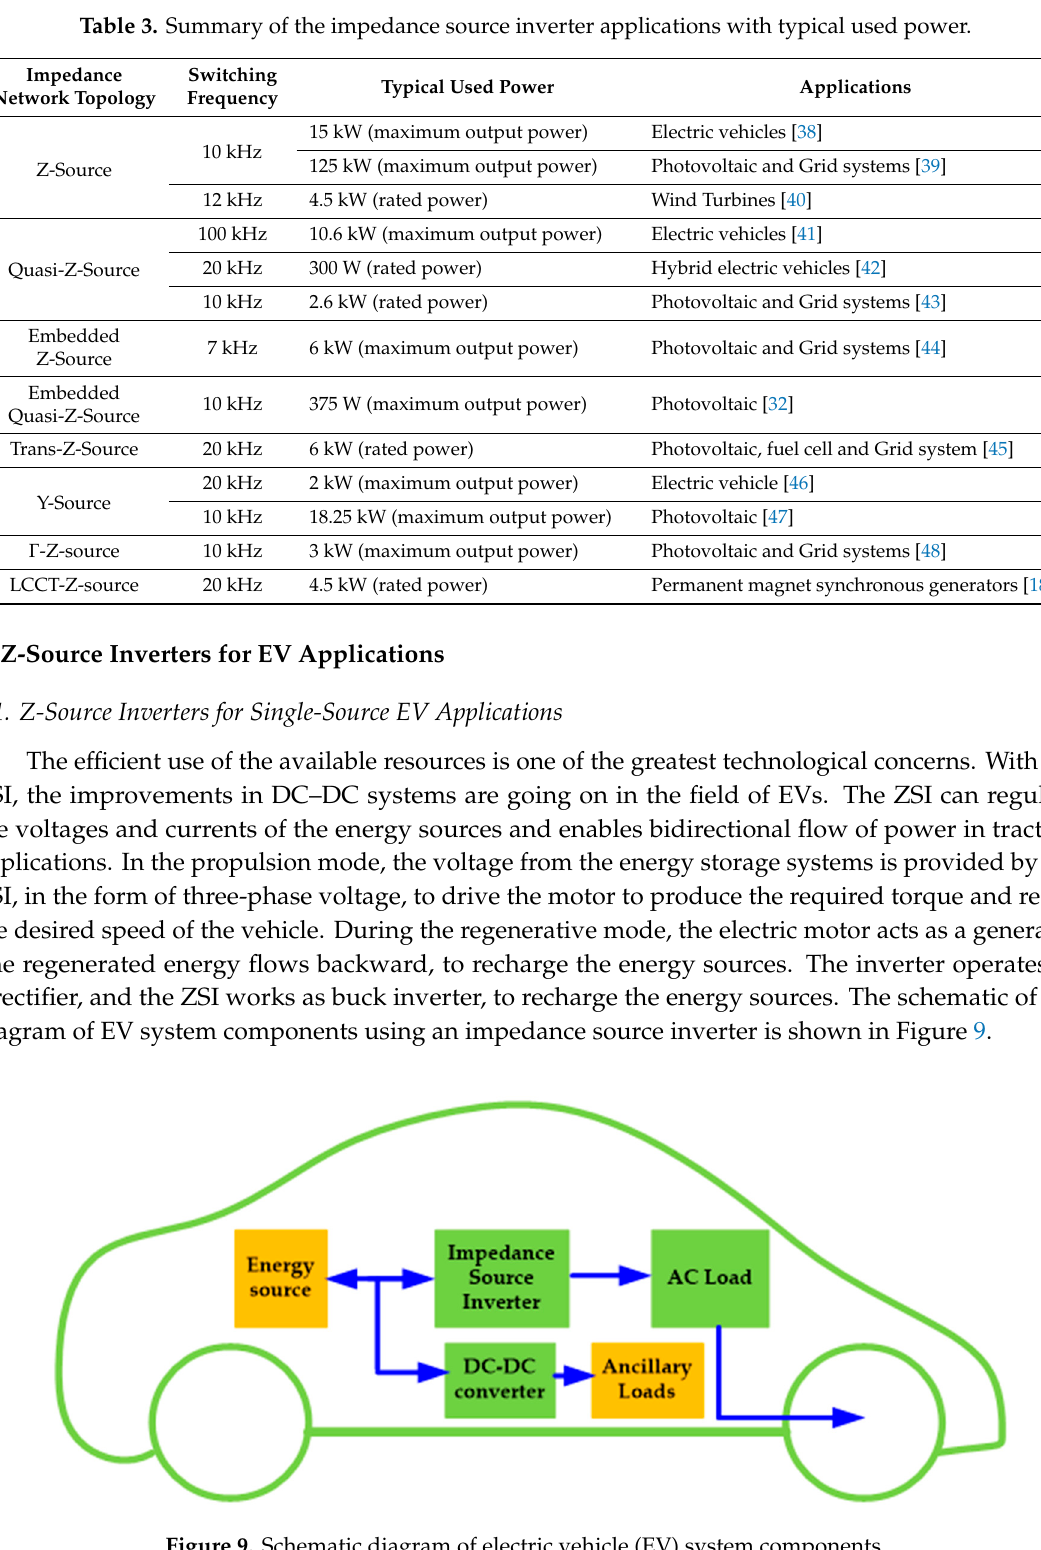
Figure 9. Schematic diagram of electric vehicle (EV) system Figure 9 . Schematic diagram of electric vehicle (EV) system components .